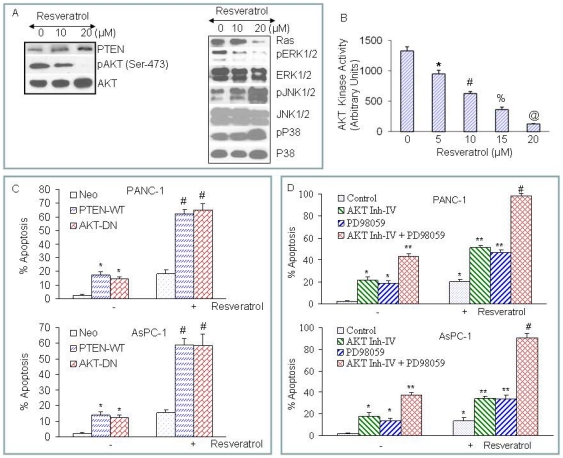
Effects of resveratrol on the expression of PTEN, AKT and MAP kinases; and the effects of PI3K/AKT and MAPK pathways on resveratrol-induced apoptosis.(A), PANC-1 cells were treated with or without resveratrol (0–20 µM) for 24 h. The cells were harvested and the expression of PTEN, phospho-AKT, AKT, Ras, phospho-ERK, ERK, phospho-JNK, JNK, phospho-p38 and p38 was measured by Western blotting. (B), AKT kinase activity. PANC-1 cells were treated with resveratrol (0–20 µM) for 24 h. AKT kinase activity was measured as we described in materials and methods. Data represent the mean ± S.D. *, #, %, and @ = significantly different from respective controls, P<0.05. (C), PTEN and dominant negative AKT enhance resveratrol-induced apoptosis. PANC-1 and AsPC-1 cells were transiently transfected with empty vector (pcDNA3.1), PTEN wild type (PTEN-WT) or dominant negative AKT (AKT-DN) along with pCMV-LacZ vector (as transfection control) for 24 h. After medium replacement, cells were treated with resveratrol (10 µM) for 48 h and, apoptosis was measured by TUNEL assay. Data represent the mean ± S.D. * and # = significantly different from respective controls, P<0.05. (D), PANC-1 and AsPC-1 cells were pretreated with AKT inhibitor IV (1 µM) and/or MEK1/2 inhibitor PD98059 (10 µM) for 2 h, followed by treatment with or without resveratrol (10 µM) for 48 h. At the end of incubation period, cells were harvested and apoptosis was measured by TUNEL assay. Data represent mean ± SD. *, ** and # = significantly different from respective controls, P<0.05.